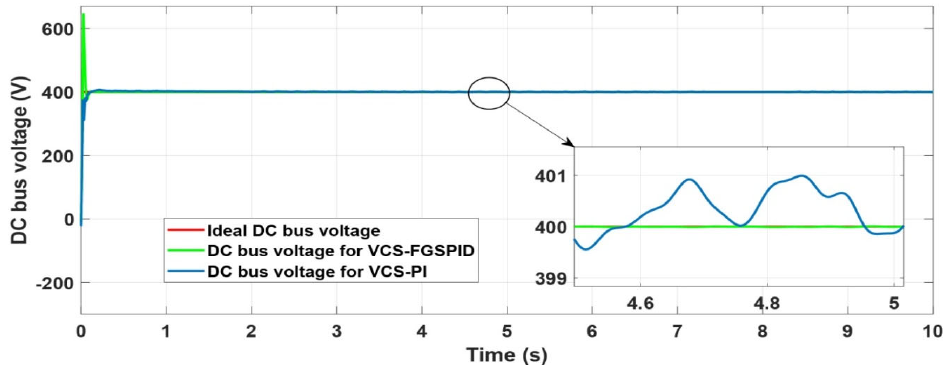
Figure 28. DC bus voltage.